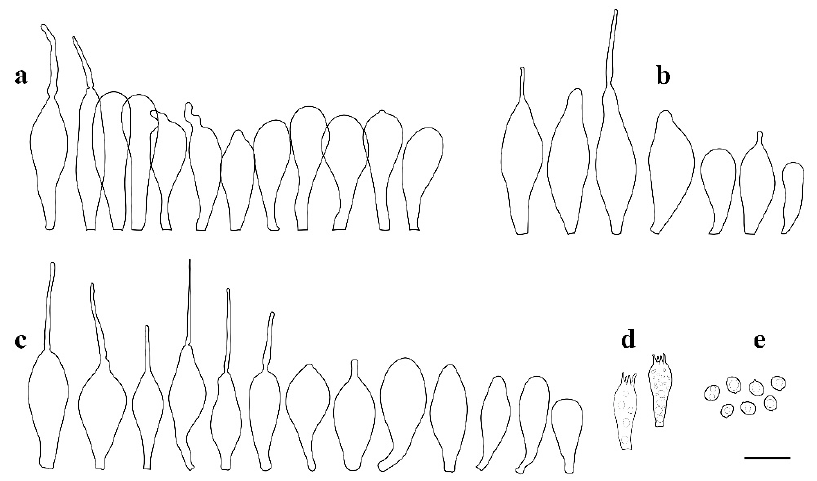
Figure 15. Pluteus reisneri FG14092019062-FG26092019042-FG29092019000: ( a ) pileipellis elements; ( b ) caulocystidia; ( c ) cheilocystidia. ( d ) basidia; ( e ) spores. Scale bar: 20